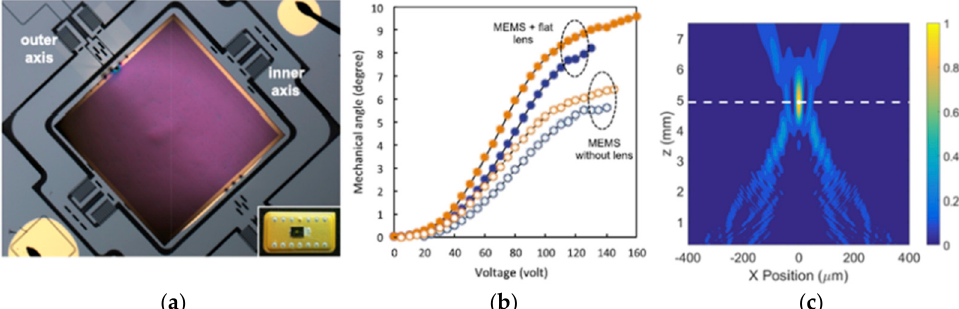
Figure 8. Metasurface-enabled MEMS ( a ) Optical microscope image of a MEMS scanner with a flat lens on top. ( b ) Angular displacement of the MEMS scanner with and without the metasurface-based lens. ( c ) Simulation: distribution of the intensity of the reflected beam in the xz − plane at y = 0. The maximum intensity occurred when z = 5 mm and focusing efficiency is 83%. (Reproduced from [47] with permission.)